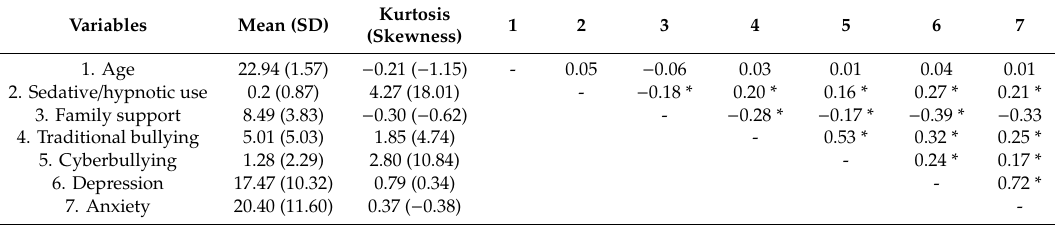
Table 1. Distribution, normality estimates, and correlation matrix for all quantitative variables ( n = 500). Variables